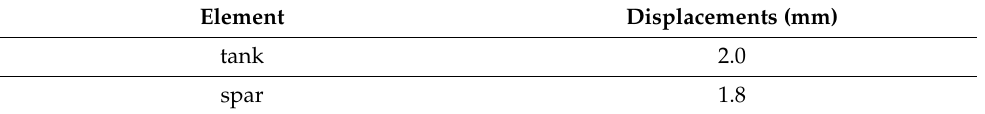
Table 3. Displacements detected during the lifting from the upper corner blocks.